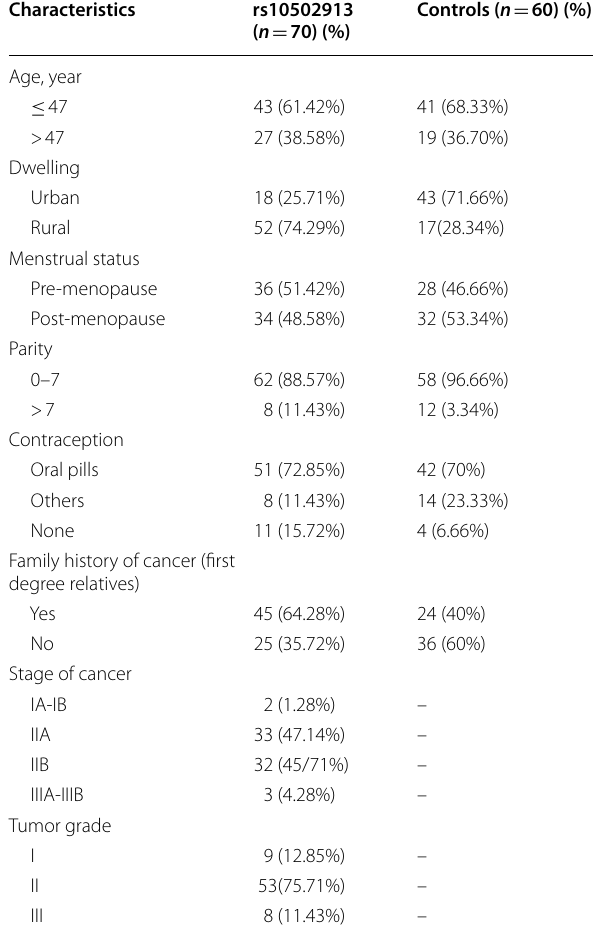
Table 1 Name of the allele, sequence of the designed primer with their size and melting point Nos. Allele Primer sequence